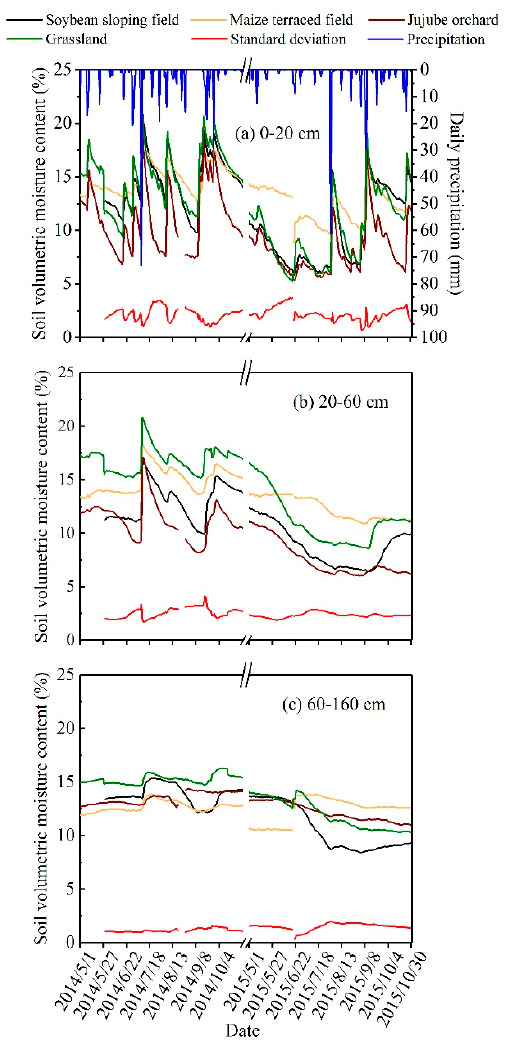
Figure 3. Dynamic changes of daily average soil moisture content in ( a ) 0–20 cm, ( b ) 20–60 cm, and ( c ) 60–160 cm soil layers and soil moisture standard deviation under different sloping land uses in 2014 and 2015 growing seasons. Due to the late installation of monitoring devices for soybean sloping field, soil moisture and temperature were collected from May 29, 2014. The standard deviation refers to the mean square error of daily average soil moisture content between soybean sloping field, maize terraced field, jujube orchard, and grassland, which can reflect the dispersion and difference in daily average soil moisture content between the four sloping land uses.